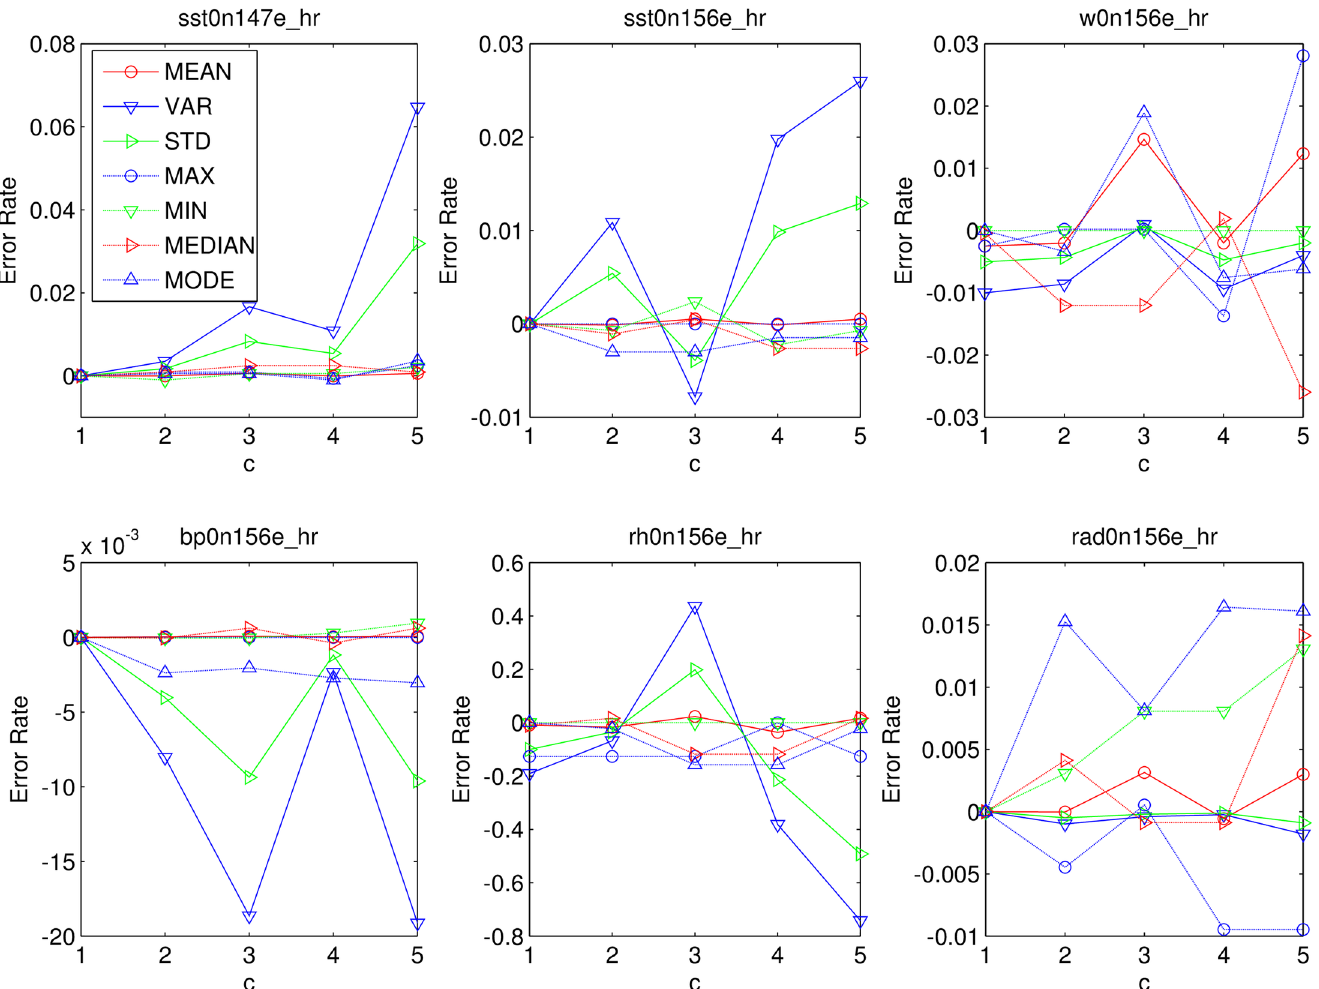
Fig 8. Accuracy Evaluation of